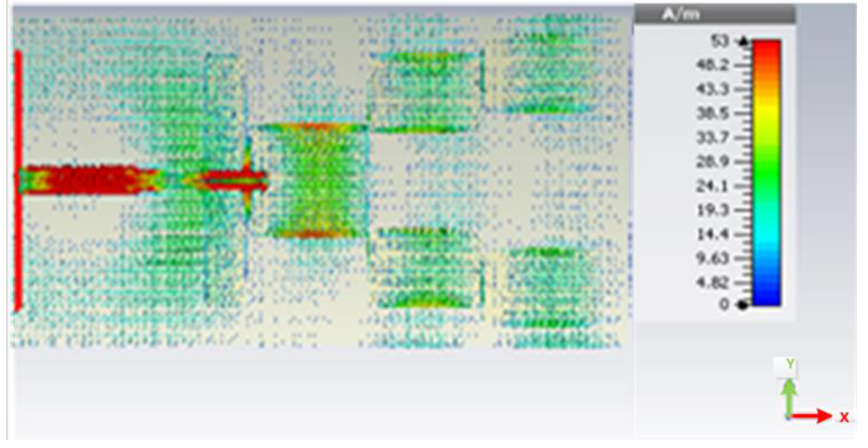
Figure 6. The surface current distribution.